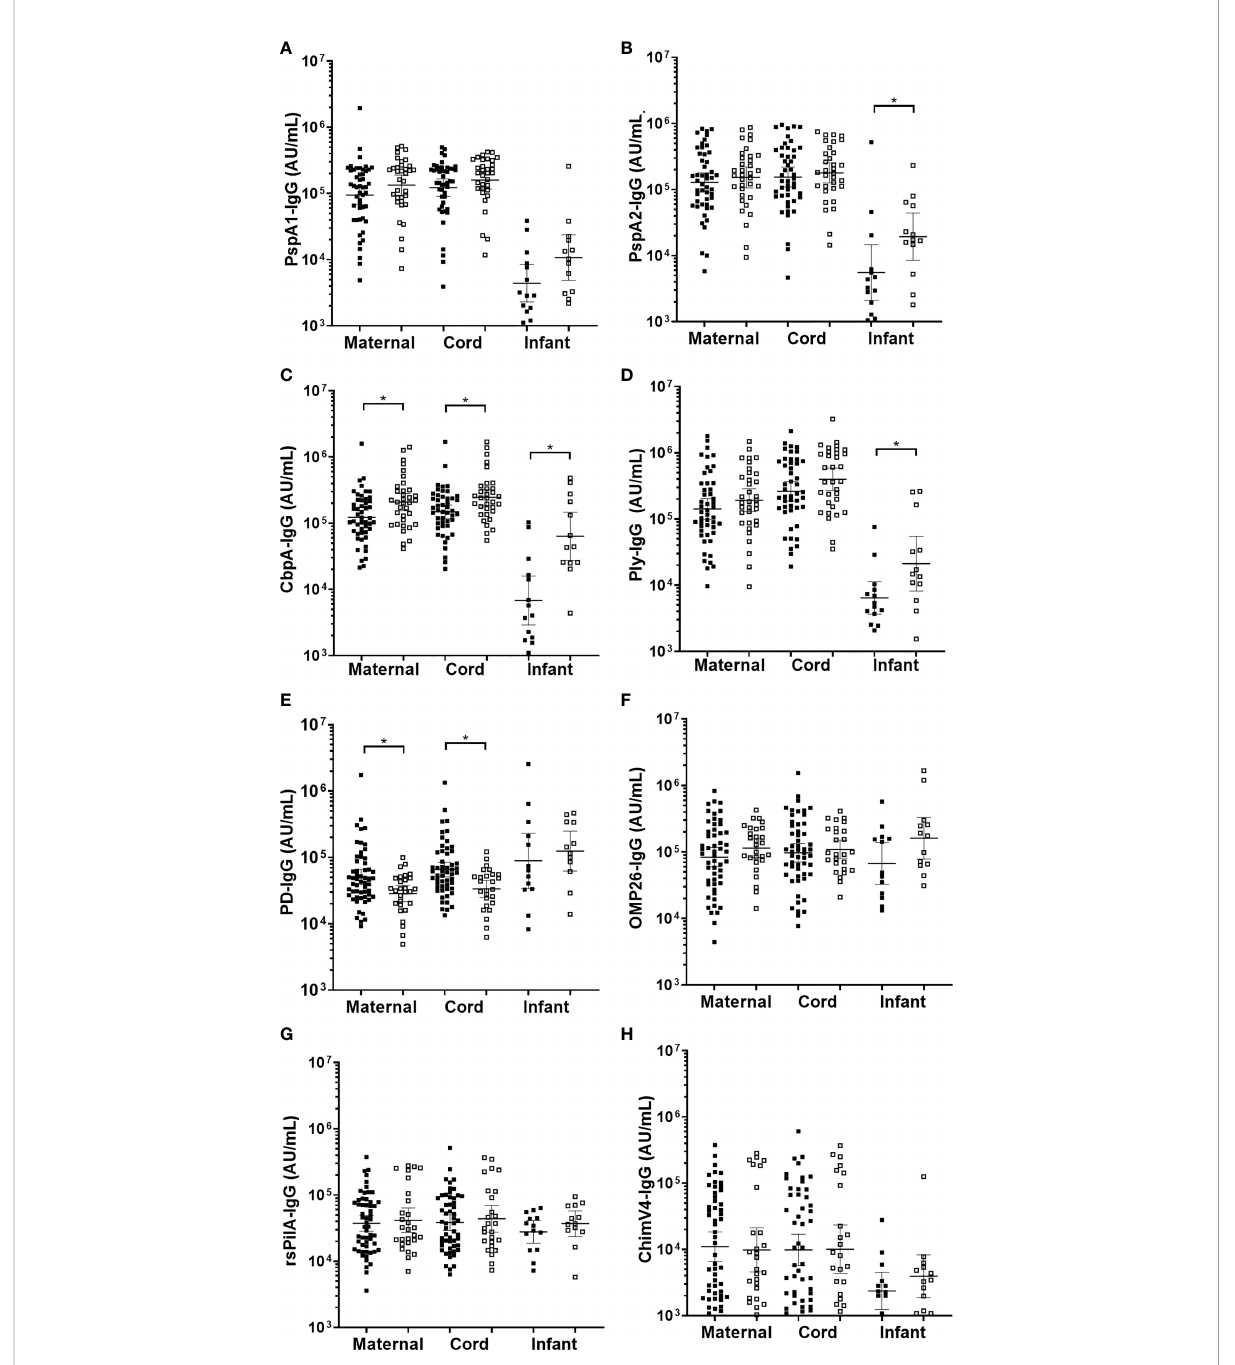
FIGURE 3 Sera IgG titres against Streptococcus pneumoniae or Haemophilus in fl uenzae separated based on any NPS positive to S. pneumoniae or NTHi in the fi rst 7-months of life, in maternal venous sera, cord sera and infant venous sera from matched mother-infant pairs. Each point represents the sera IgG titres against S. pneumoniae antigens (A) PspA1, (B) PspA2, (C) CbpA, (D) Ply and H. in fl uenzae antigens (E) PD, (F) OMP26, (G) rsPilA and (H) ChimV4. PspA1, pneumococcal surface protein A family 1; PspA2, pneumococcal surface protein A family 2; CbpA, choline-binding protein A; Ply, pneumolysin. PD, Protein D; OMP26, outer membrane protein 26; rsPilA, recombinant soluble pilus A protein; ChimV4, chimeric vaccine antigen 4 (rsPilA and P5). *p-value <0.05, Unpaired t-tests were conducted on logarithmically transformed data. Positive NPS = open